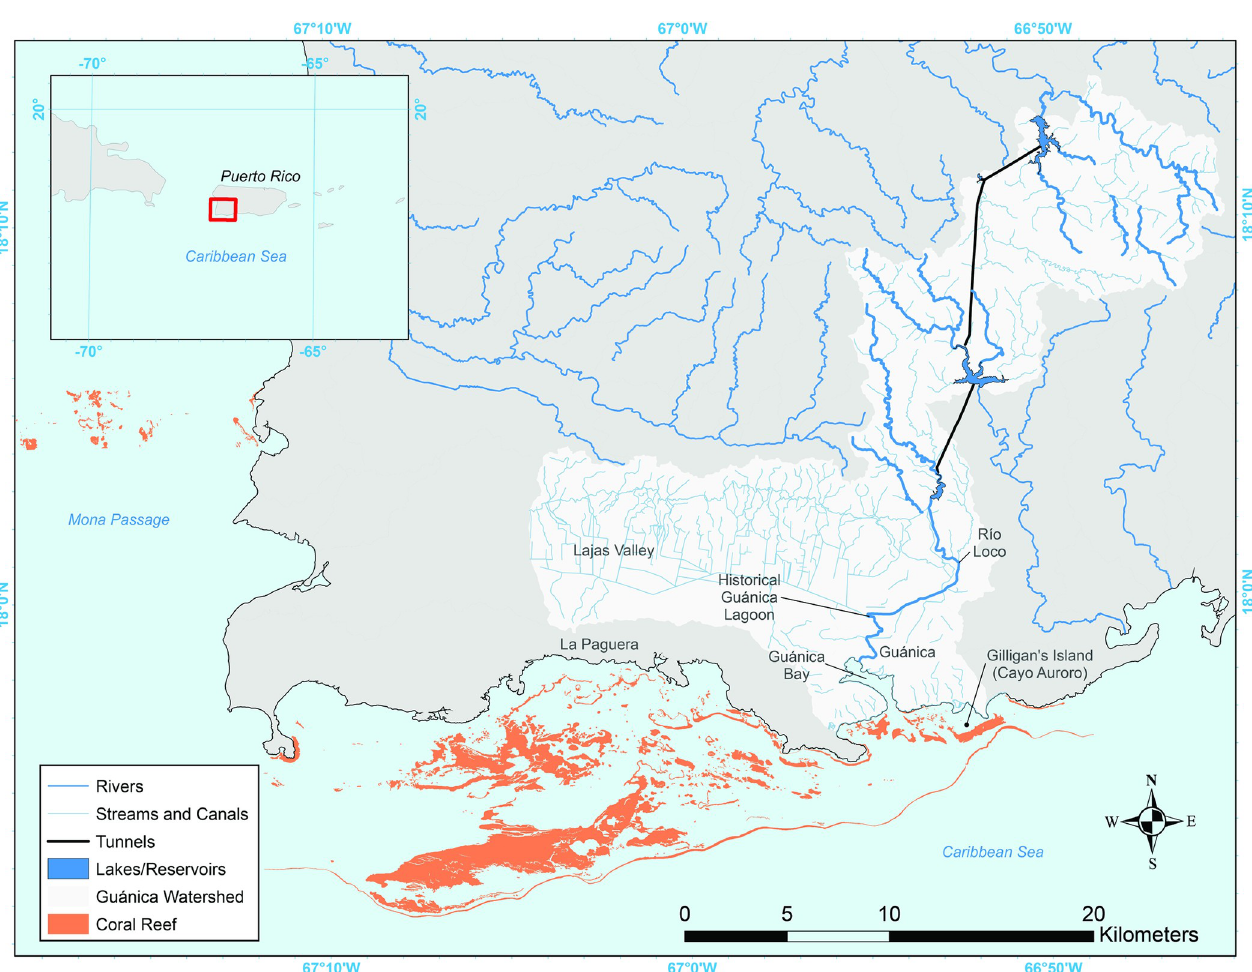
Fig 3. Map of the Gua´nica Bay watershed and southwest Puerto Rico reef. Rivers and streams from [25] and coral extent from [26].